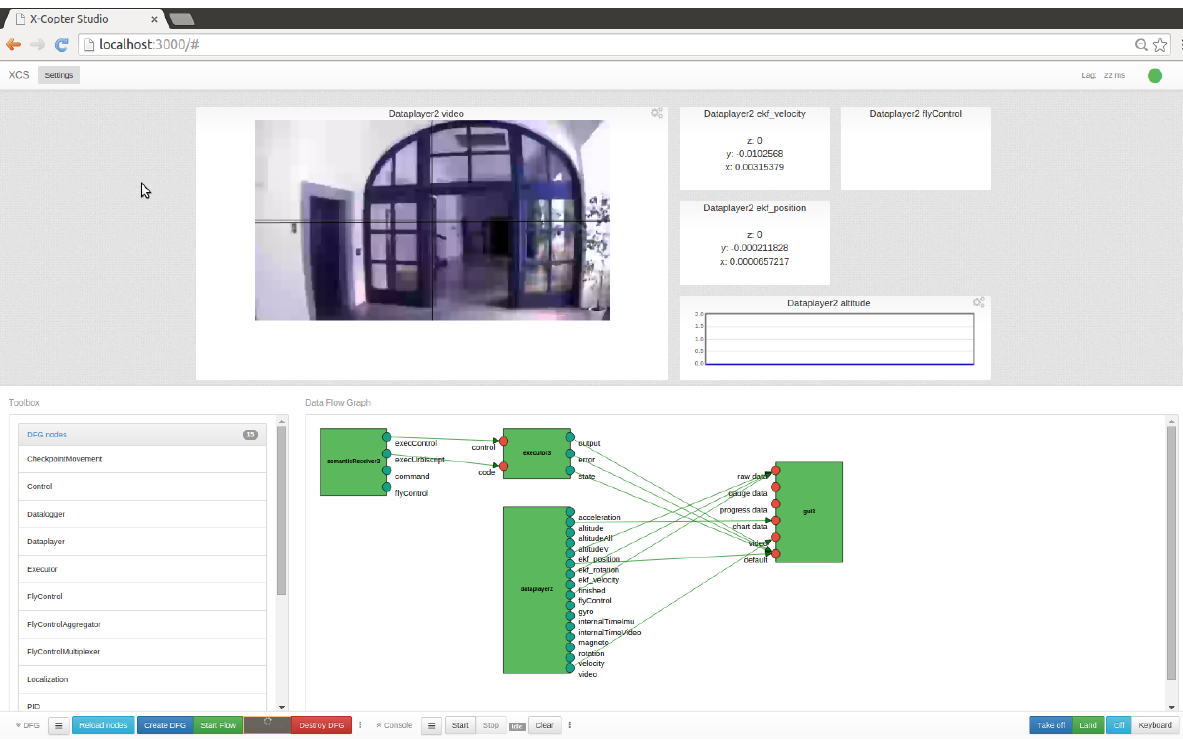
Figure 2. X-Copter Studio GUI. Top navbar indicated connection quality, upper half is filled with widgets that display data from the onboard, lower half accommodates the editor with repository of nodes on the left, and connected nodes on the right. At the bottom there are (left to right): dataflow control buttons, scripting console control buttons and manual flight control buttons. The scripting console is hidden.